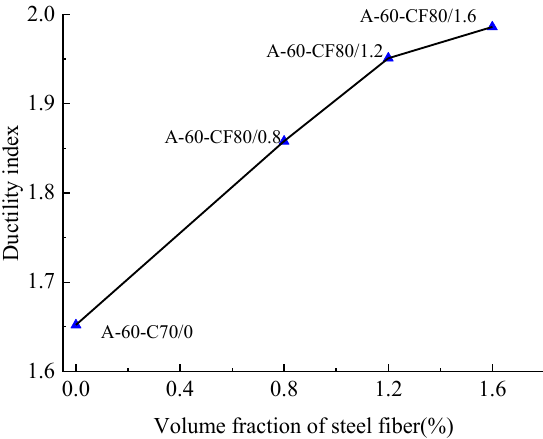
Figure 12. Changes of ductility index with the volume fraction of steel fiber.